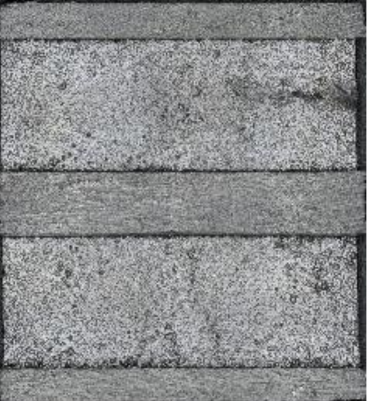
Figure 9. Surface quality W303, magnification 10 × .